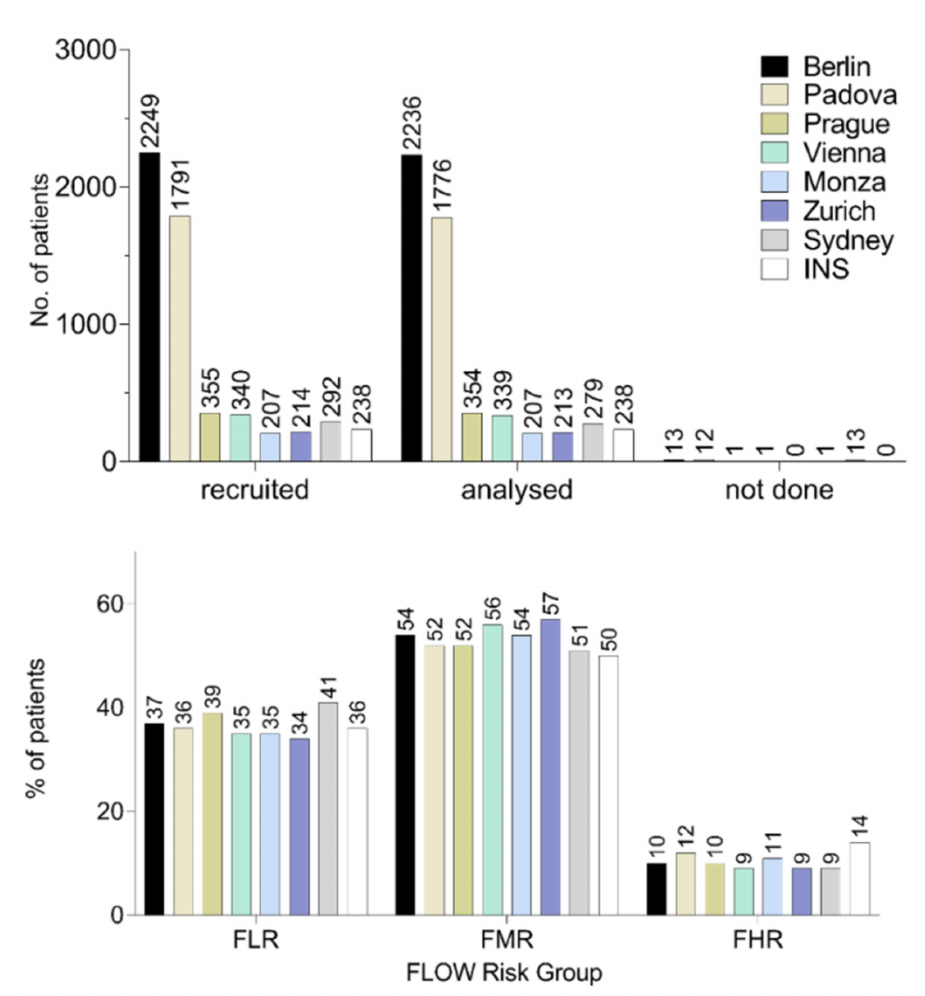
Figure 5. Homogeneity of B-ALL risk classification data of well-trained and matured centers within the AIEOP-BFM ALL 2009 trial. In a survey including nine AIEOP-BFM FLOW reference laboratories from eight countries, independent data of FCM-MRD-based risk classification of B-ALL on day 15 were collected and compared. Statistical analysis was performed using GraphPad Prism 8.3.0. FHR, Flow high risk; FLR, Flow low risk; FMR, Flow medium risk; INS, contains combined data from the two reference laboratories in